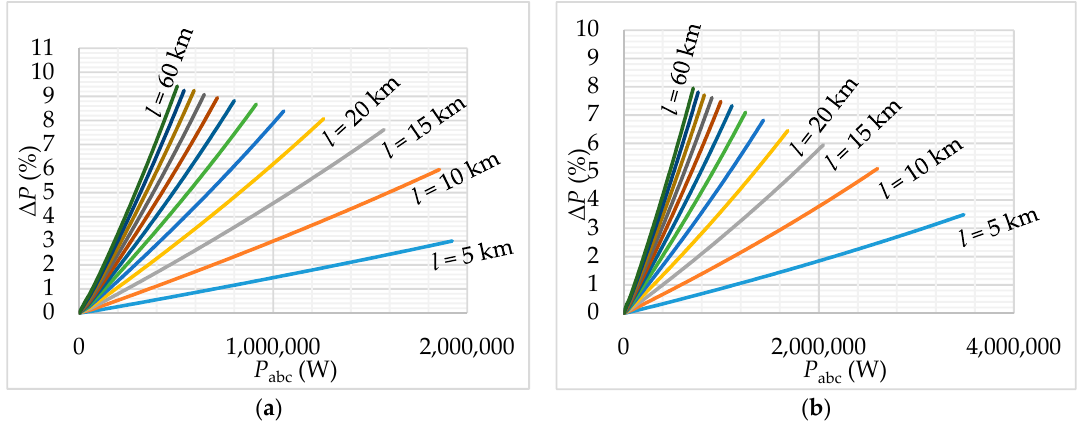
Figure 8. Scenario 2: ( a ) ACSR 42/7; ( b ) ACSR 70/11.